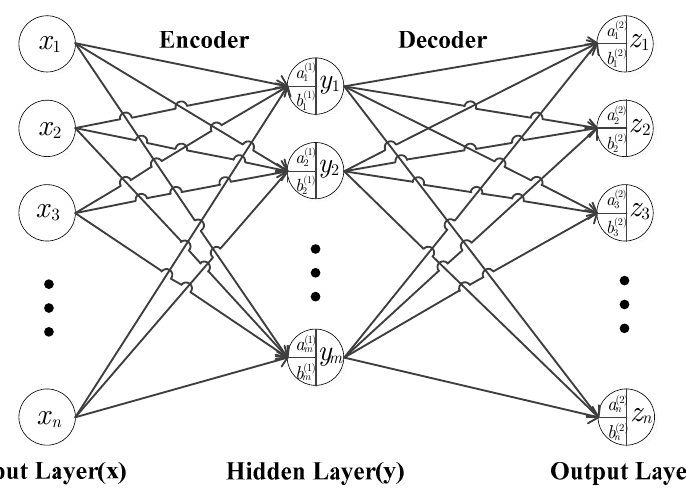
Figure 2. Single-layer AE neural networks structure.